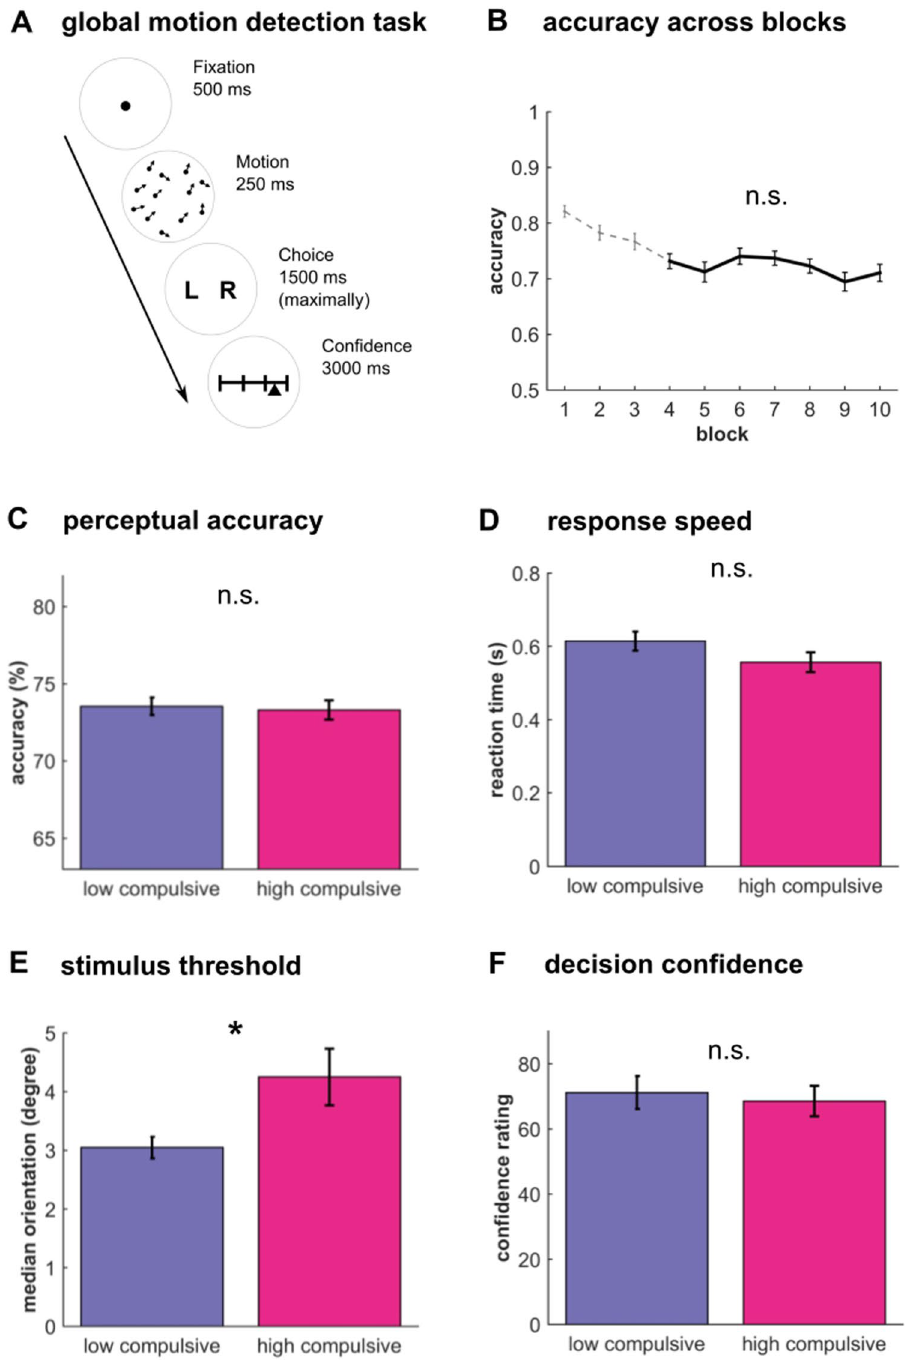
Figure 1. Metacognition task performance. High and low compulsive participants performed a metacognition task. ( A ) Participants saw a cloud of dots moving with a defined mean motion orientation plus added random movement noise. After participants’ categorical judgement of the main direction of stimuli they then had to rate their confidence using a visual slider. ( B ) A staircase procedure ensured that performance was stable (the first three block were omitted (dotted line), because stability was not yet reached). This staircase ensured that both groups performed at the same level ( C ) and did not differ in their mean reaction times ( D ). Mean confidence ratings were similar between groups ( F ), but the sensory signal was significantly stronger in high compulsives ( E ), indicating a poorer perceptual decision making performance in high compulsive participants. Bar plots: mean ± 1s.e.m; * p < 0.05; n.s. p >